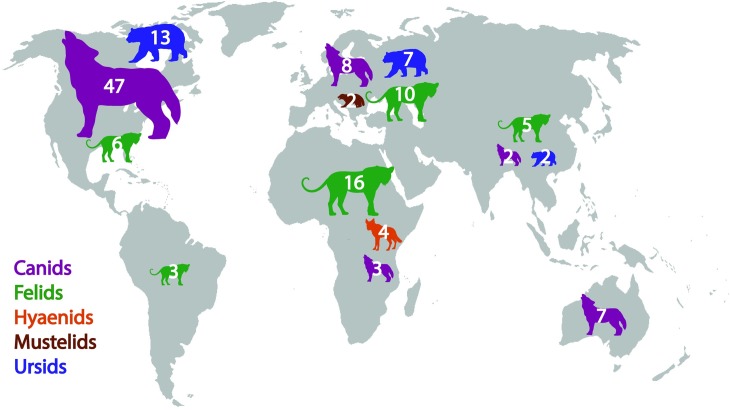
Number of studies included in four independent reviews published in 2016–2018, presented by carnivore family and continent.Canids include gray wolves and subspecies (Canis lupus), coyotes (C. latrans), dingoes (C. dingo), black-backed jackals (C. mesomelas), African wild dogs (Lycaon pictus), red foxes (Vulpes vulpes), and domestic dogs (C. familiaris). Felids include Eurasian lynx (Lynx lynx), cougars (Puma concolor), lions (Panthera leo), jaguars (P. onca), leopards (P. pardus), snow leopards (P. uncia), caracals (Caracal caracal), and cheetahs (Acinonyx jubatus). Hyaenids include spotted hyenas (Crocuta crocuta). Mustelids feature wolverines (Gulo gulo). Ursids include American black bears (Ursus americanus), Asiatic black bears (U. thibetanus), brown or grizzly bears (U. arctos), and polar bears (U. maritimus). Smaller carnivores (e.g., red foxes, hyenas, and caracals) are included in studies that investigated multiple carnivore species of varying sizes.